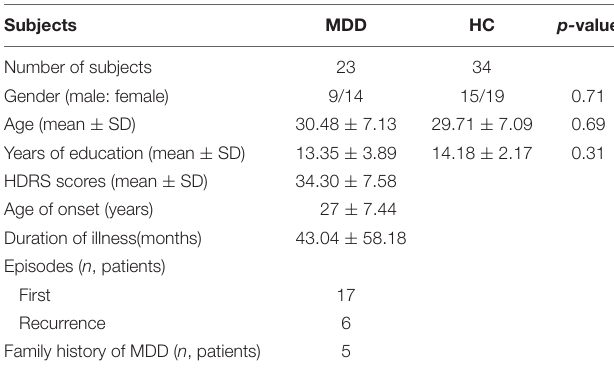
A Pearson chi-squared test was used for gender comparison. Two-sample t-tests were used for age, education comparisons. HDRS, Hamilton Depression Rating Scale scores; MDD, major depression disorder; HC, healthy